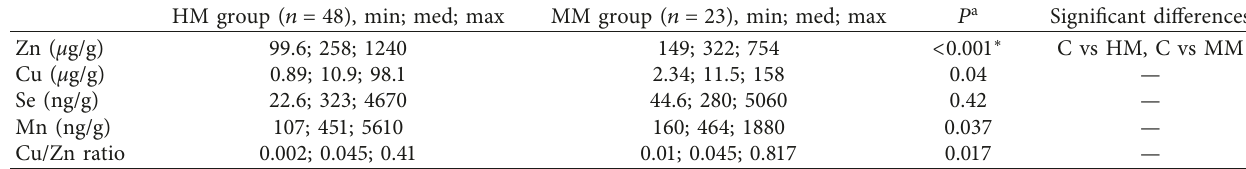
a P value for Kruskal–Wallis test.